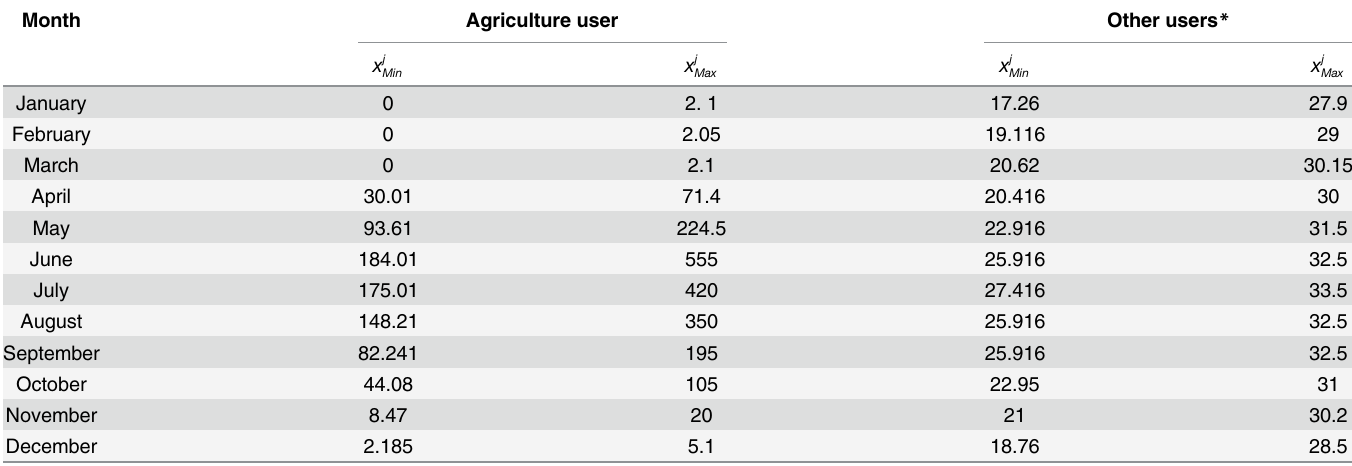
Table 2. The given allocated water which results in the maximum and minimum values of the utility function for different users (MCM).